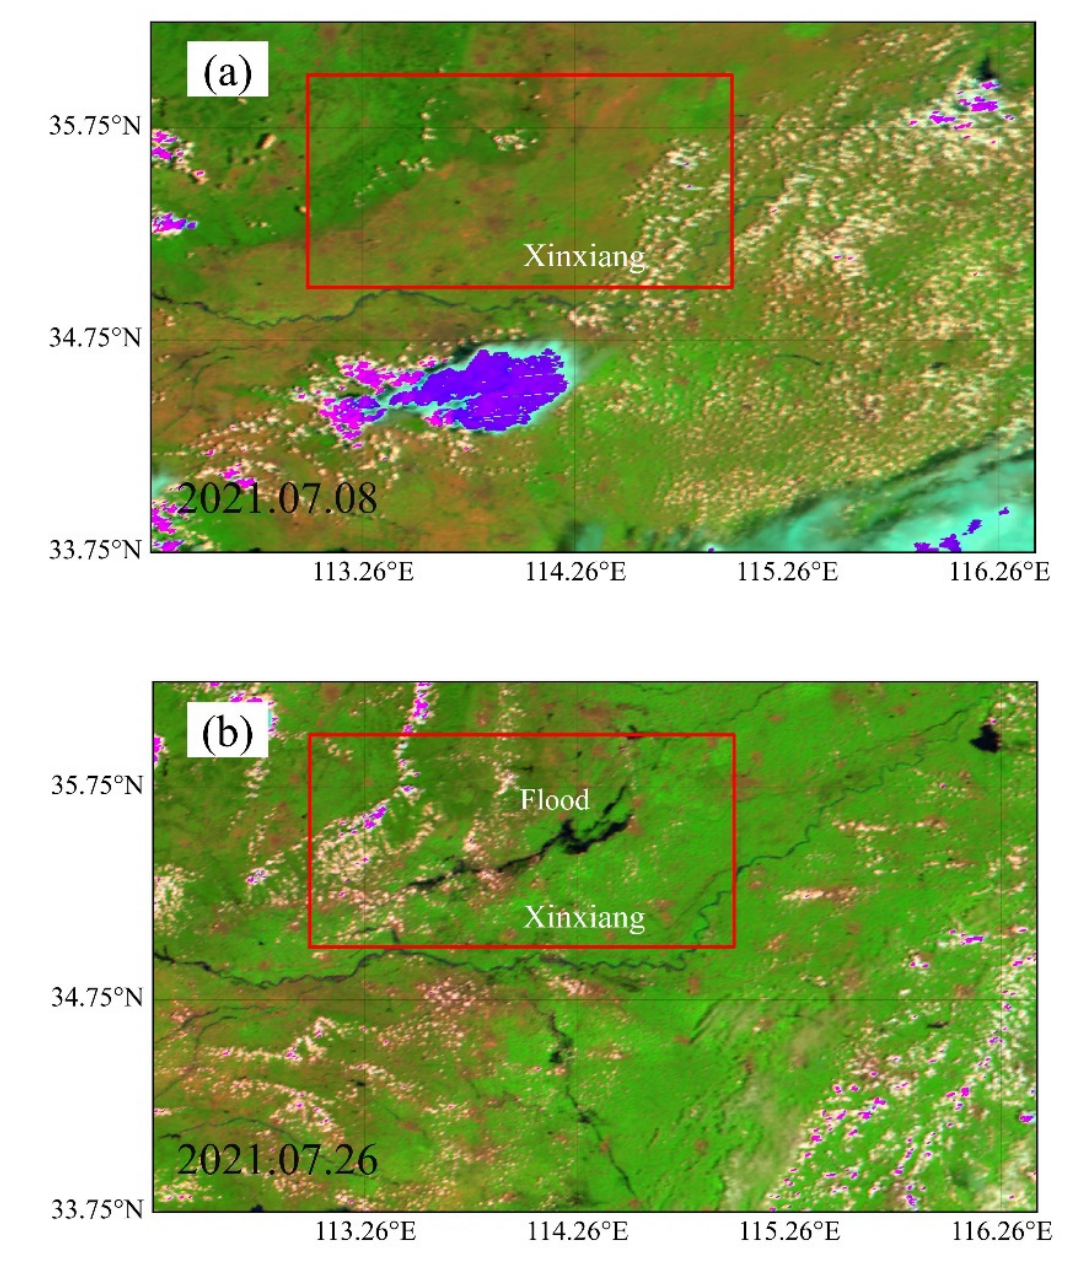
Figure 13. Images of the northern part of Henan Province, China derived from MODIS on 8 July 2021 ( a ) and 26 July 2021 ( b ). Water bodies and clouds are in black color and purple color, respectively. The flooding area in Xinxiang is marked out with red rectangle.